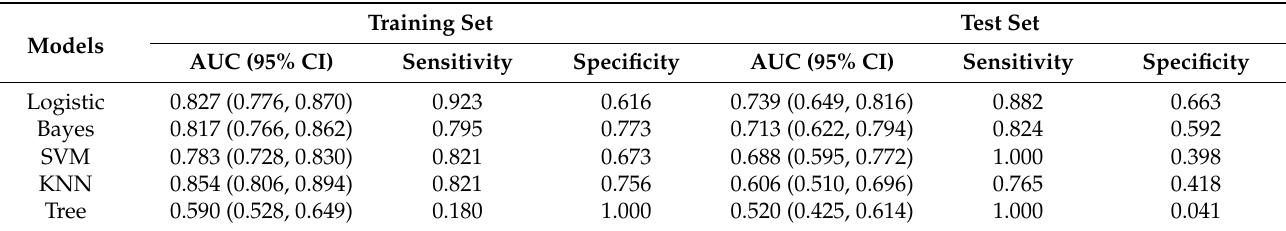
Table 3. Predictive performance of different models in training and test